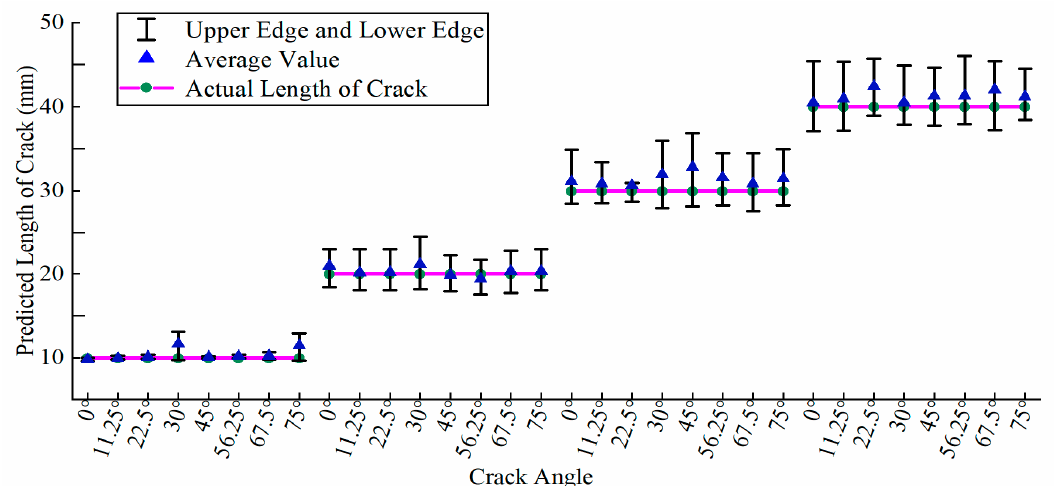
Figure 11. Length prediction of cracks at different angles (Multi-BPNN).